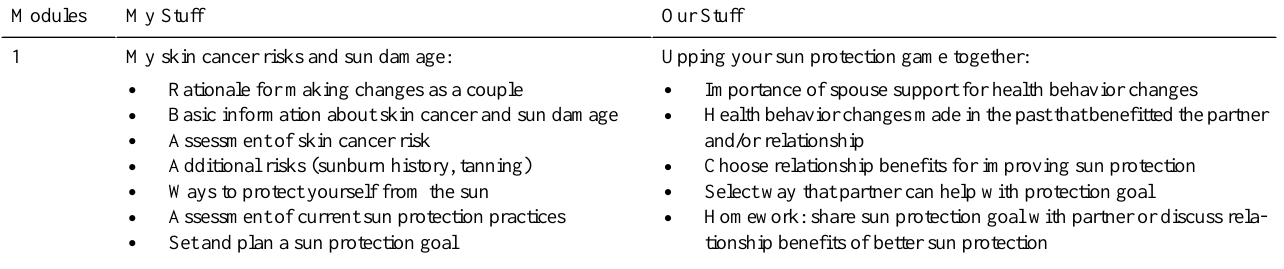
Table 2. Information on content of the Sun Safe Partners Online modules.